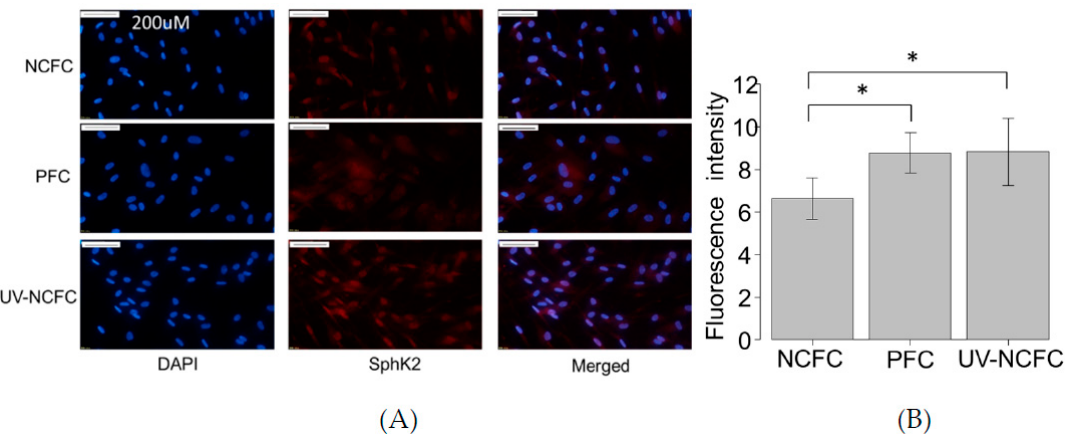
Figure 4. ( A ) Immunocytochemistry of SphK2 in NCFCs, PFCs, and UV-NCFC. The left panels show cells that were stained with DAPI (4’,6-diamidino-2-phenylindole). The middle panels show cells stained for SphK2. The right panels show a merged image. SphK2 was upregulated in PFCs and UV-NCFCs compared to NCFCs. Bar, 200 µm. ( B ) Quantitative results based on immunocytochemistry. Five images of each experiments were taken and the fluorescence intensities were quantified. Data are presented as the mean ± standard deviation. * p < 0.05.